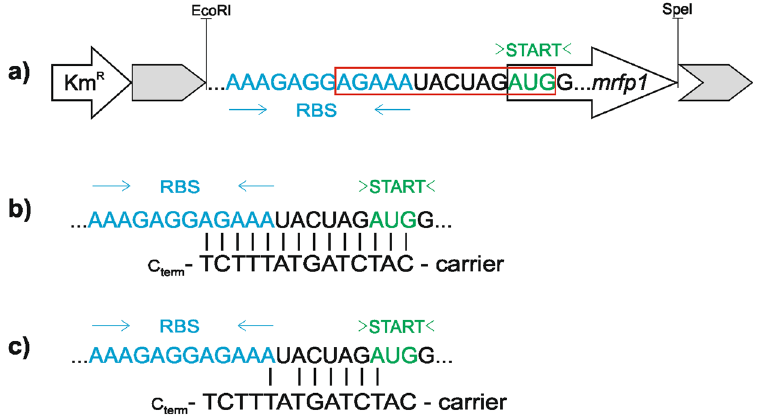
Figure 2. ( a ) Schematic representation and construction strategy of mrfp1 expression plasmid pBBR(rfp). The red rectangle surrounds the mRNA target site for the PNA sequence. Km R refers to the kanamycin resistance marker; gray arrows represent the lacZ gene encoding β -galactosidase, disrupted by the insert (RBS and mrfp1) . The plasmid contains two other structural elements: rep and mob which were not included in the figure. ( b ) Anti- mrfp1 PNA sequence. c) Control scrambled PNA. The carrier is either (KFF) 3 K or vitamin B 12